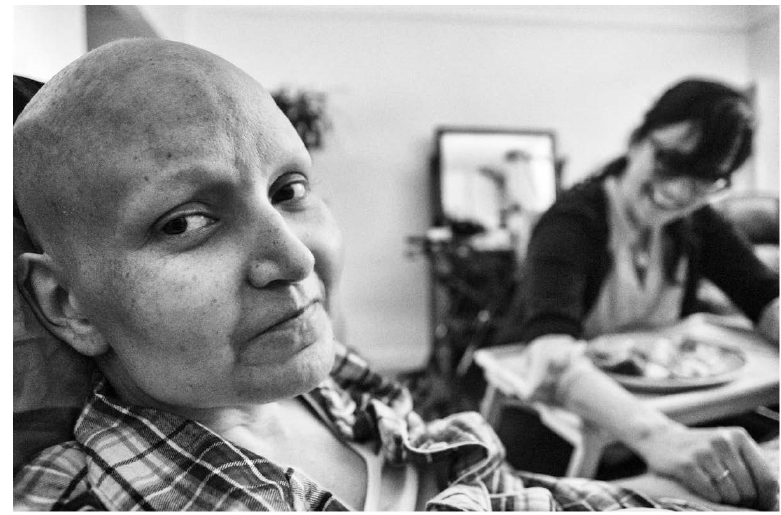
Figure 3. Courtesy Angelo Merendino, The Battle we Didn’t Choose—My Wife’s Fight with Breast Cancer . One of the last images in Merendino’s e-book depicts an empty transferrable hospital bed (Figure 4). This last image feels hollow and silent. The hospital bed is detached from the sofa, gesturing towards a physical separation. The cover is smoothed out, a bedsheet is folded, and two pillows are placed in the middle of the bed. There is a similar arrangement on the sofa-bed—three pillows are placed on top and some folded sheets or towels are visible in the right-hand corner of the image. The two beds mirror each other. The photograph is taken from a high angle, giving the illusion that the photographer and the viewer are hovering above. At the top centre of the image there is a photograph of Jennifer with an elderly man, presumably her father, looking back at the viewer. The image of Jennifer here “answers the need to include the virtual presence of those who are otherwise absent” (Batchen 2004, p. 12). The bed reveals what was once there, the void. The presence here contrasts with absence. Despite Jennifer’s death, her presence can be felt in the image that looks back at us. In the absence of Jennifer, we must draw sense from absence, making absence a presence.